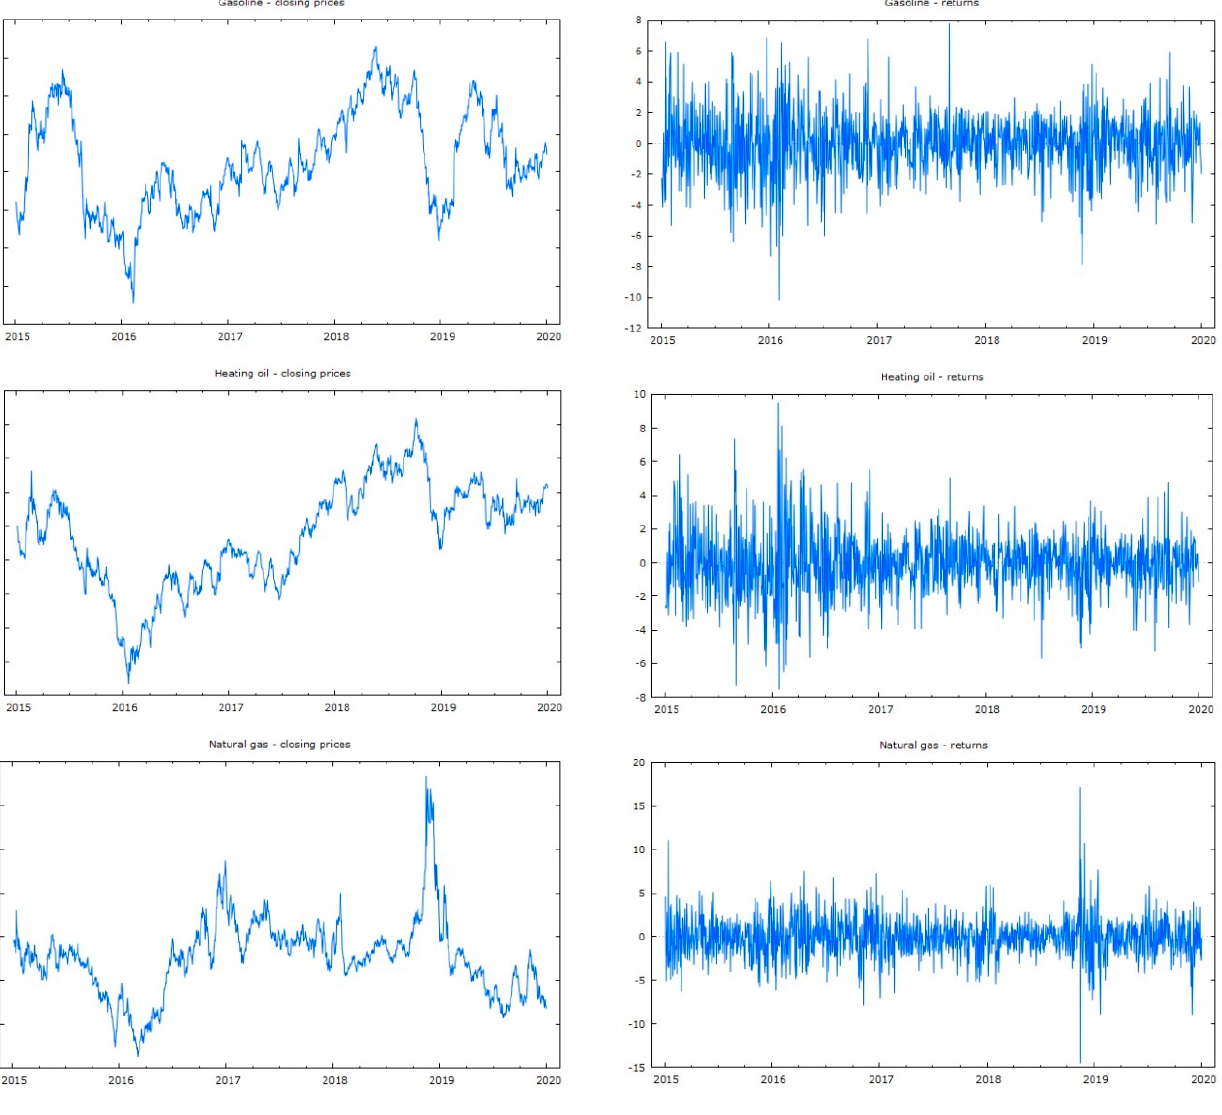
Figure 1. Daily closing prices and open-to-close returns of the investigated energy commodities.